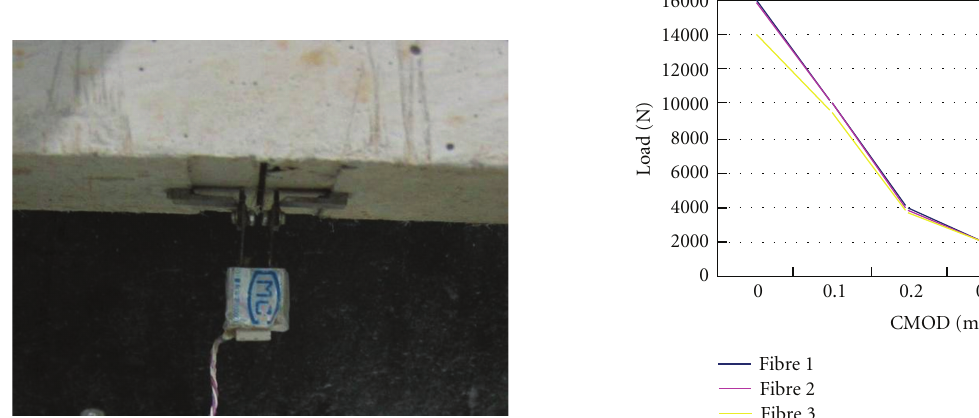
Figure 3: Crack opening displacement test.